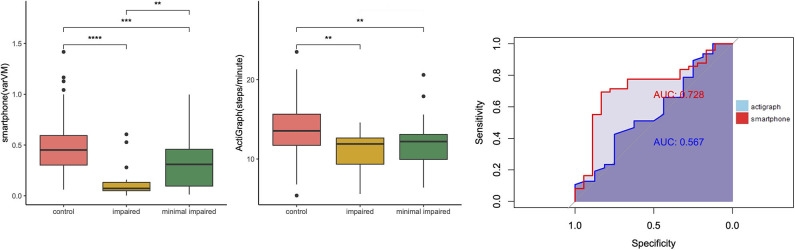
Group differences between ambulatory minimally impaired and ambulatory impaired patients with multiple sclerosis (pwMS). Left: Boxplots showing differences between controls minimally ambulatory impaired pwMS [Extended Disability Status Scale (EDSS) <3.5] and severely impaired pwMS (EDSS > 3.5), **p < 0.01, ***p < 0.001, ****p < 0.0001. Right: receiver operating characteristic (ROC) curves of smartphone (red) and ActiGraph (blue) showing the ability of differentiation of levels of ambulatory impairment.